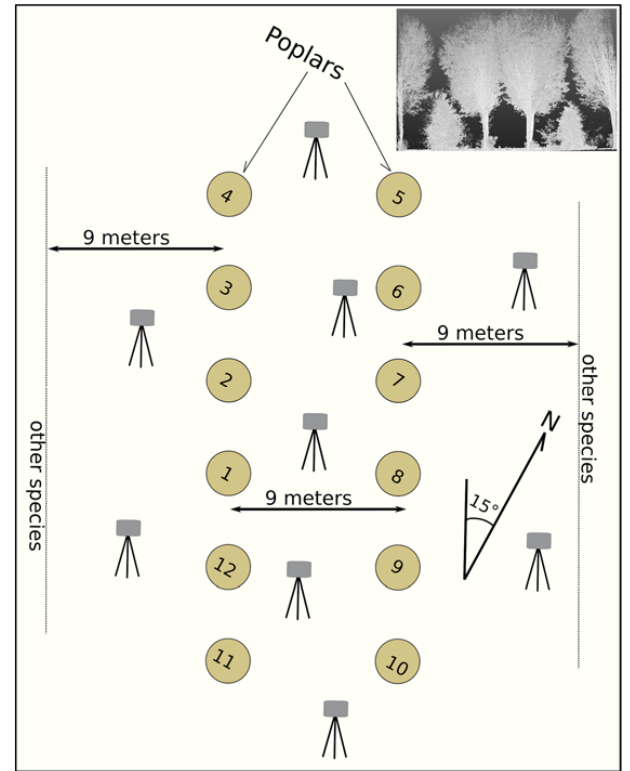
Figure 1. Experimental design. Circles represent the 12 studied stems of each plot. Distances along the row vary by plot (from 4 to 5 m). Each plot was scanned 9 times, moving the device in the positions marked in the schematic map. In the upper right side, a point cloud profile in P450 is